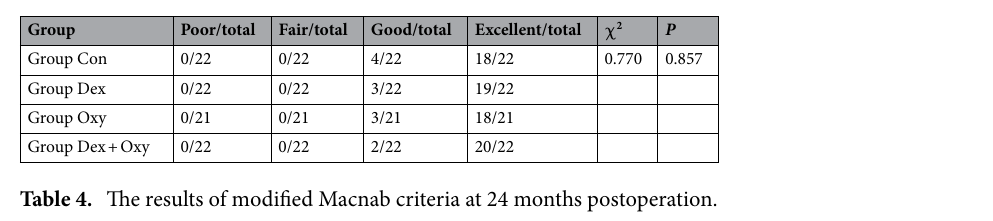
Table 4. The results of modified Macnab criteria at 24 months